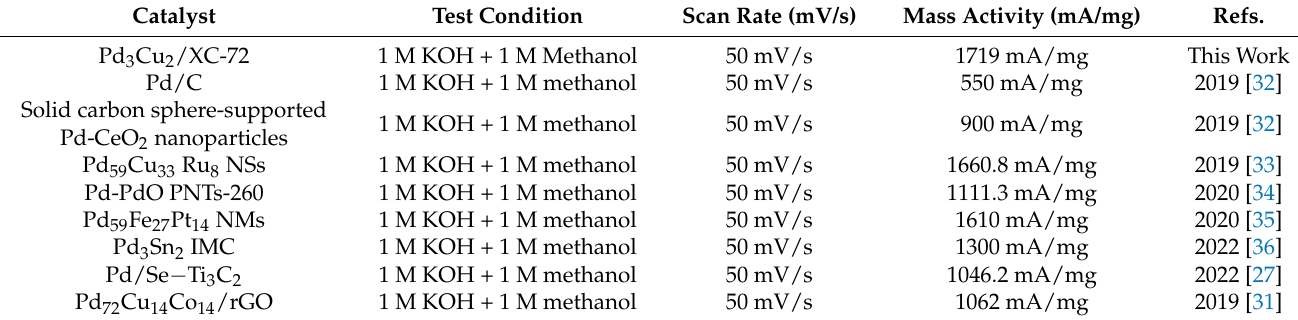
Figure 6. CVs in 1.0 M KOH + 1.0 M CH 3 OH-purged N 2 at 50 mVs − 1 . Table 2. Performance comparison of different palladium-based catalysts. Table 2. Performance comparison of different palladium-based catalysts.